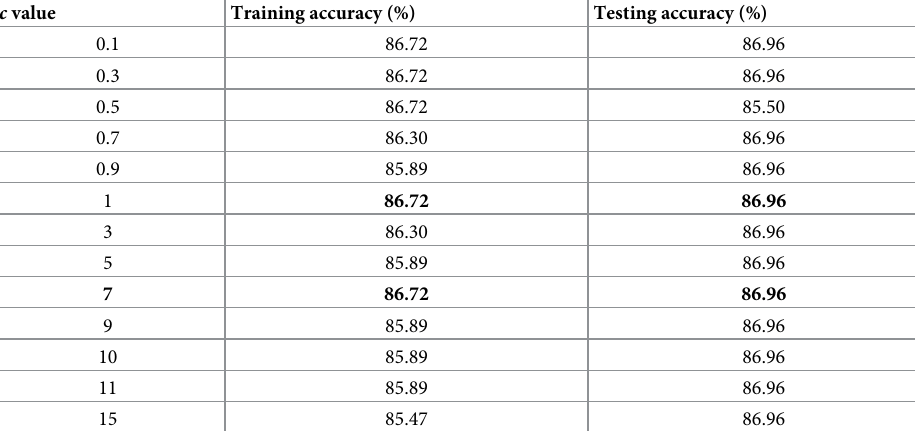
Table 8. Accuracy of bagging SVM with different values of c